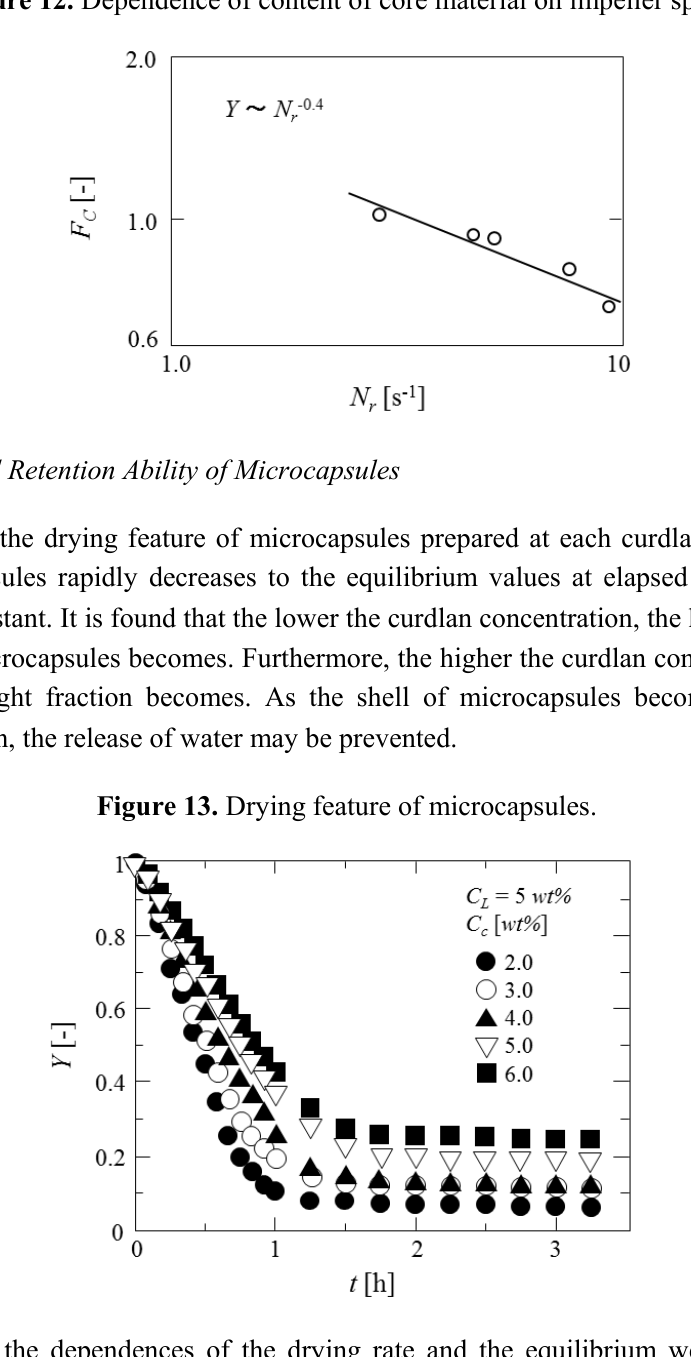
Figure 12. Dependence of content of core material on impeller speed.